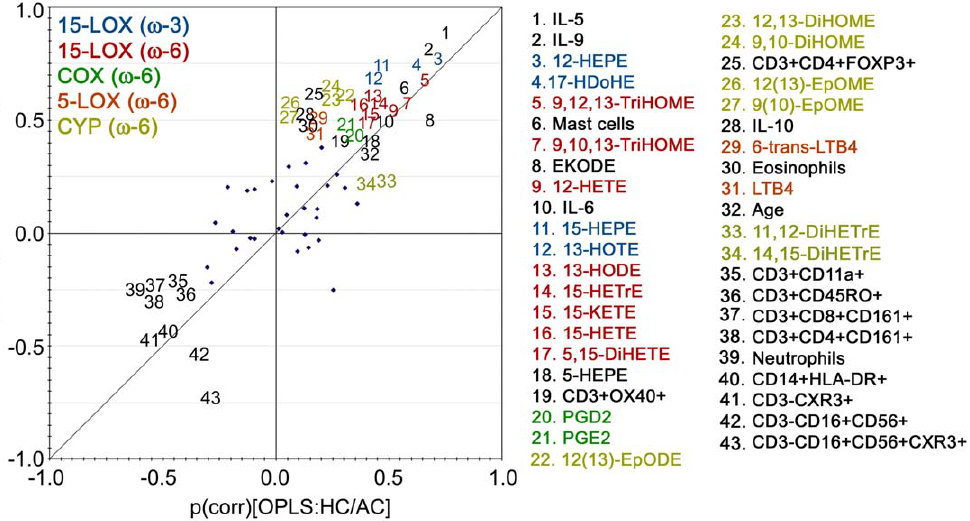
Figure 4. Shared and Unique Structures (SUS) plot. SUS plot correlating the OPLS models of healthy controls versus asthmatic controls (Baseline Asthmatics, Figure 3A, X-axis) and healthy controls versus asthmatics following provocation (Provoked Asthmatics, Figure 3B, Y-axis). A complete list of p(corr) values for both models is provided in Table S7. Abbreviations are as follows: 15-lipoxygenease (15-LOX), cyclooxygenase (COX), 5-lipoxygenase (5-LOX), cytochrome P450 (CYP), v -6 fatty acid ( v -6), v -3 fatty acid ( v -3), healthy controls (HC), asthmatic controls (AC) and asthmatics following provocation (AFP). Colors are as follows: 15-LOX-derived v -3 oxylipins (blue), 15-LOX-derived v -6 oxylipins (red), COX-derived v - 6 oxylipins (green), 5-LOX-derived v -6 oxylipins (orange), CYP-derived v -6 oxylipins (gold). Variables with p(corr) $ |0.4| are labeled, while those # |0.4| are shown as symbols.